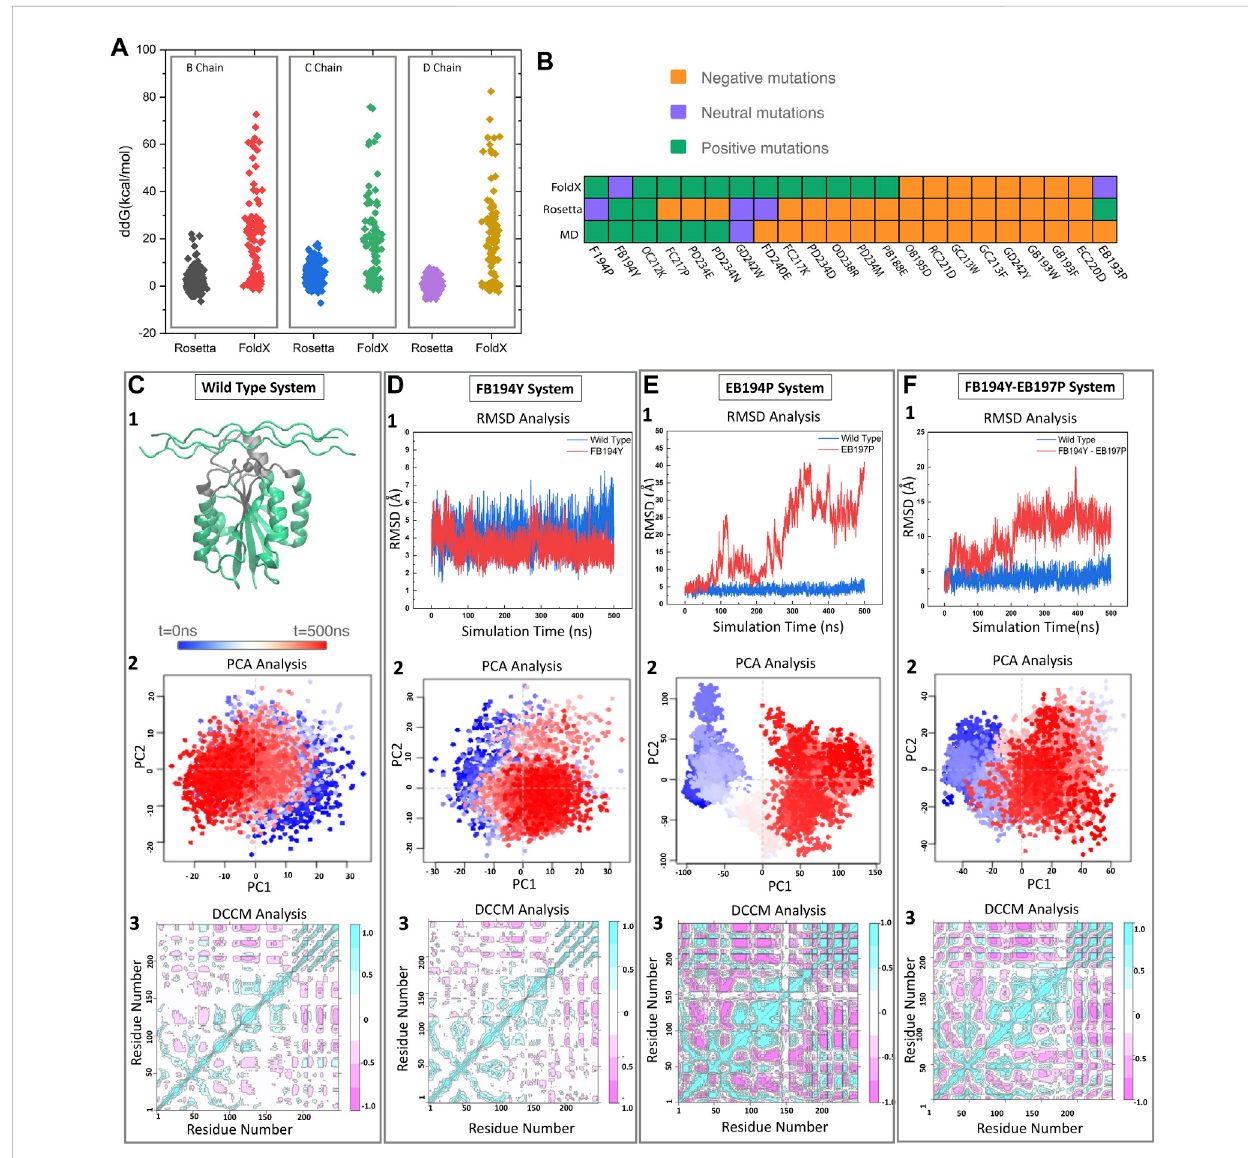
FIGURE 2 Pipelinefor selectingnewmotifs. (A) FoldXand Rosettaareusedtoestimaterelativefreeenergychangesuponmutating eachresidueinthebinding motif to all possible amino acids. (B) Predicted effect of mutations by three different methods (FoldX, Rosetta, and MD) for a set of 22 mutations. (C) The wild type samples a single state throughout the trajectory as identi fi ed by projecting onto the two fi rst principal components. Reference Dynamic cross correlation matrix (DCCM) for the wild type state. (D – F) Examples of a stable (D) and unstable (E,F) mutations as identi fi ed from RMSD, PCA, and